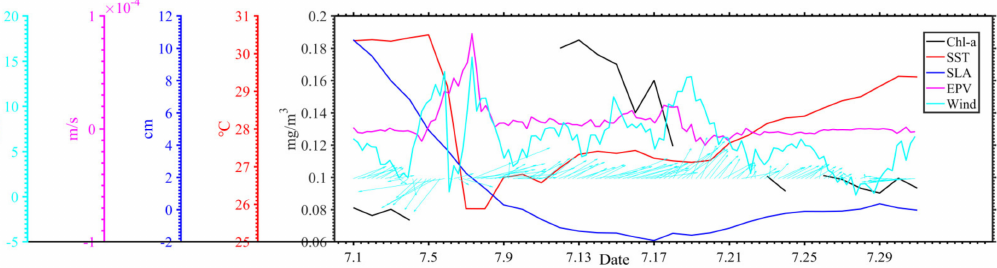
Figure 12. Time series of Chl- a concentration, sea surface temperature, sea level anomaly, Ekman pumping velocity, and wind speed (vector) in the open ocean where the typhoon